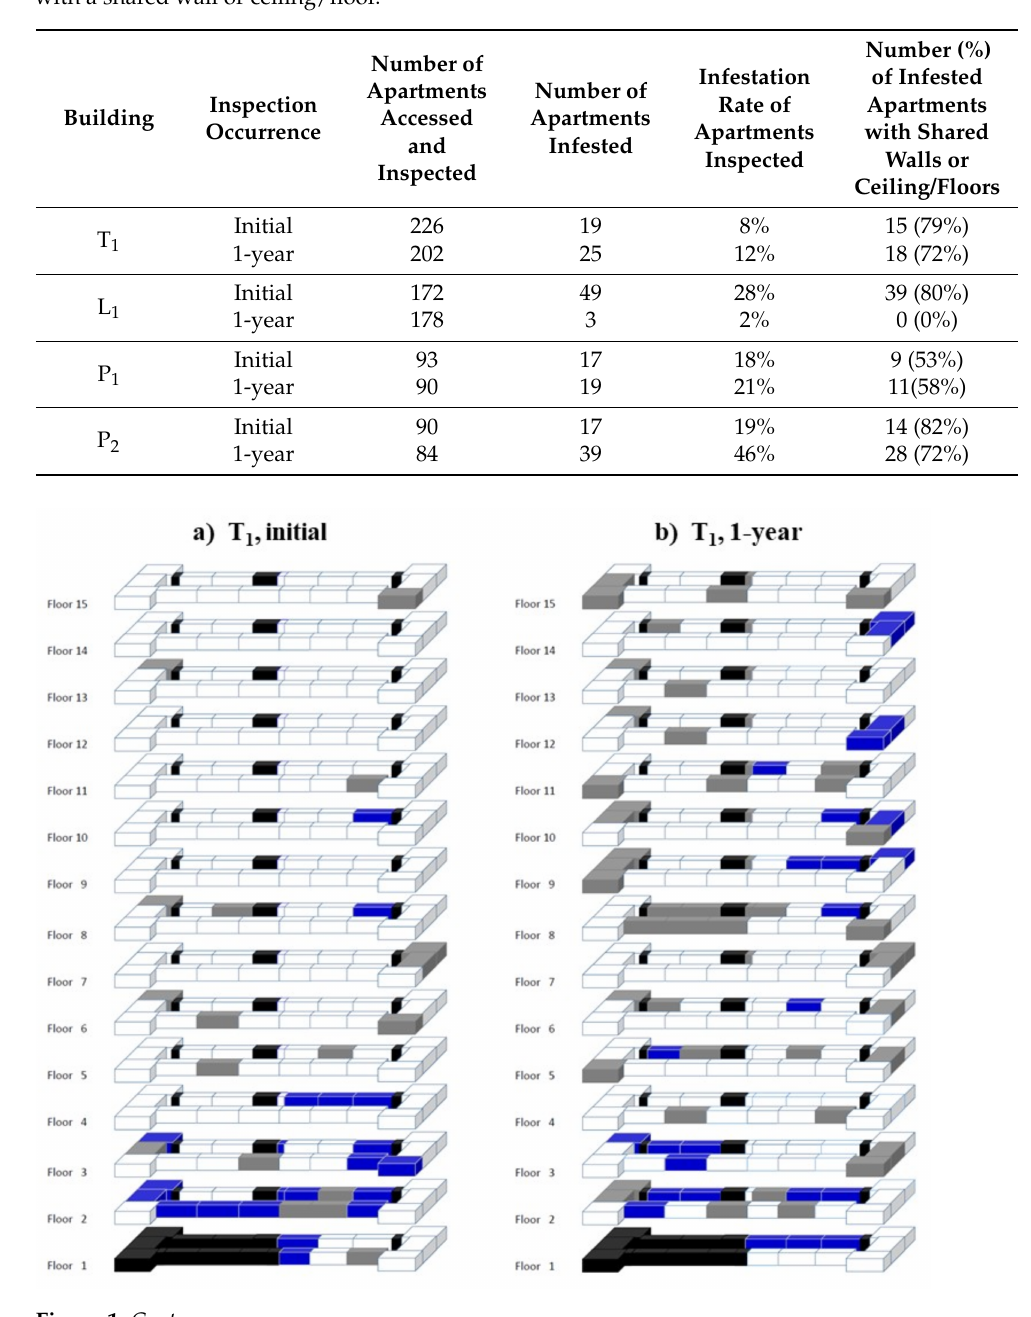
Table 2. Summary of apartments with house mouse infestations and the proportion of apartments with a shared wall or ceiling/floor.